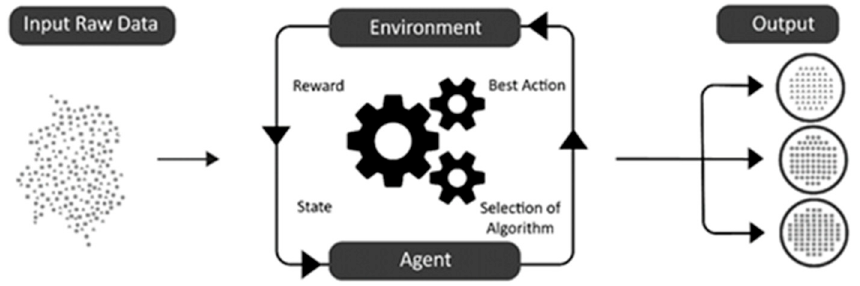
Figure 6. How reinforcement learning works.